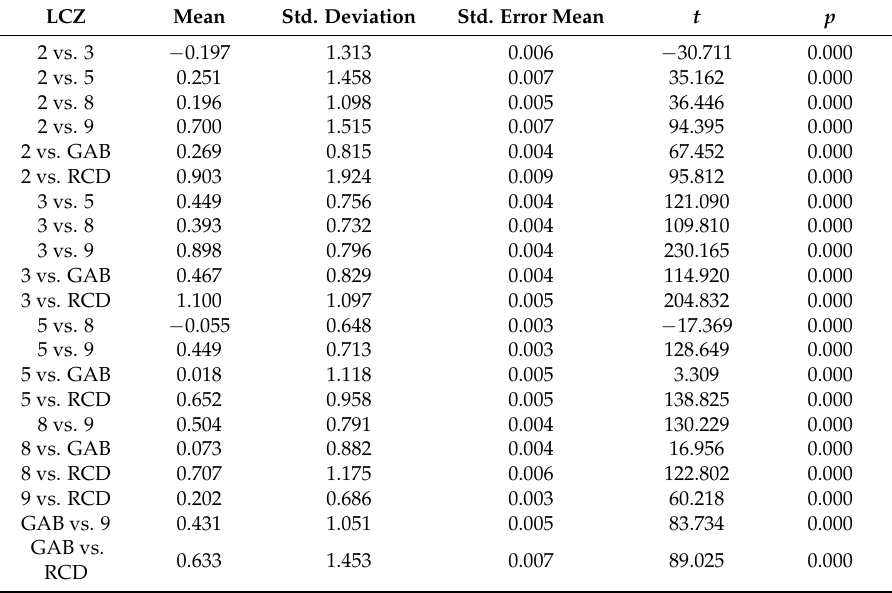
Table 3. Paired samples t -test results for the average temperature in the different LCZs.